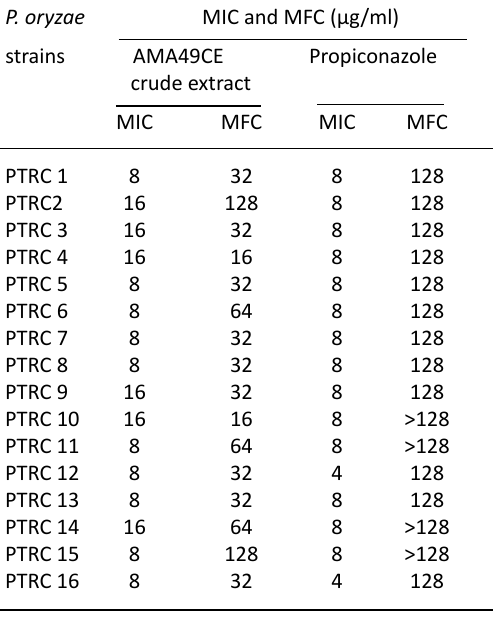
Table 3 . Antifungal activity of cell ethyl acetate crude extract from Streptomyces sp. AMA49 (AMA49CE) against pathogenic strains of P. oryzae